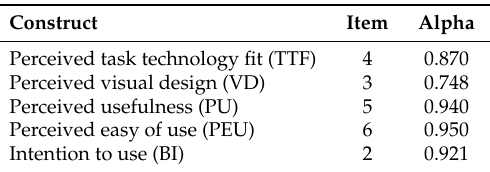
Table 4. Coefficient